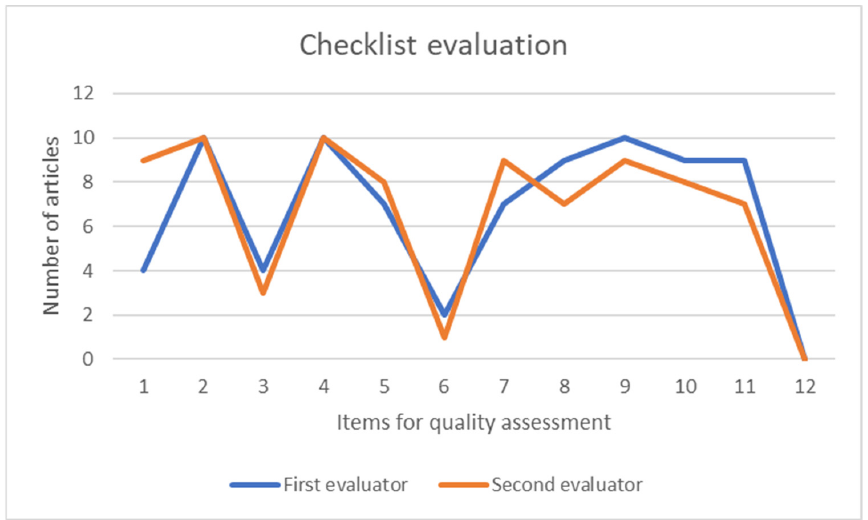
Figure 2. Plot of the number of selected articles that satisfy each of the items of the checklist used.